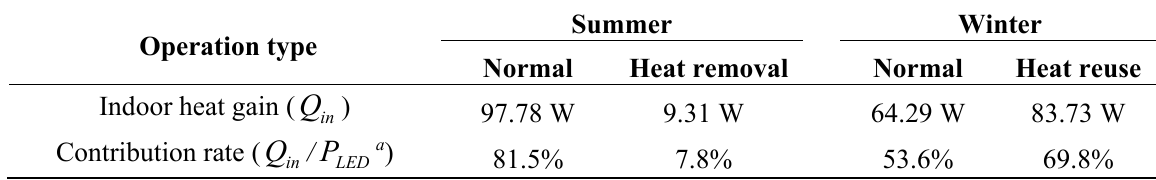
Figure 6. Indoor heat gain effect of ATOS seasonal strategy (blue: heat removal in summer; red: heat reuse in winter). Table 3. Experimental results with and without the ATOS